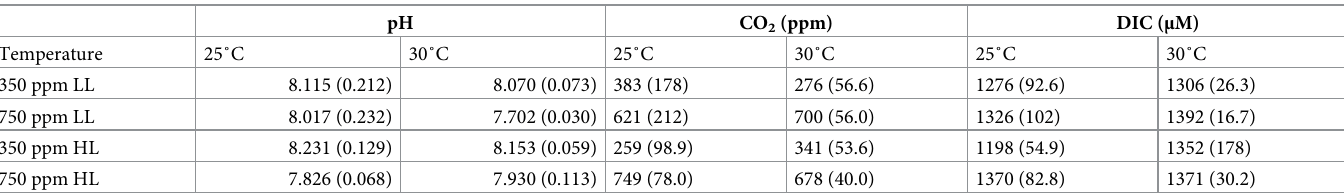
Table 2. pH, CO 2 and DIC for each treatment (+/- standard